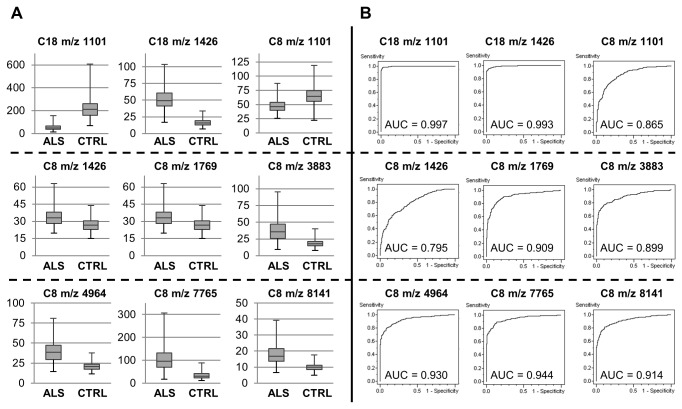
Peak variance and ROC curves.A/ Representation of the expression level for some of the most discriminating C8- or C18-peaks (x-axis, peak intensity), B/ corresponding receiver operating characteristic curve (ROC) with ALS group define as positive class.